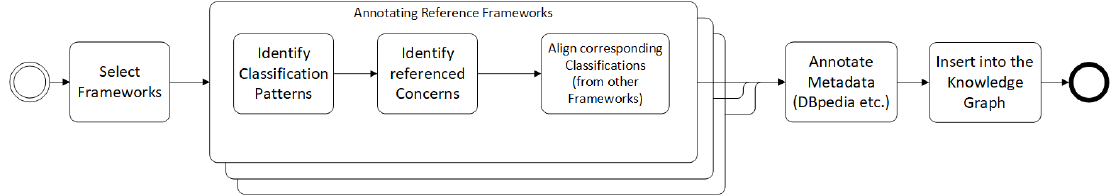
Figure 1. Processing steps to insert reference frameworks into the knowledge